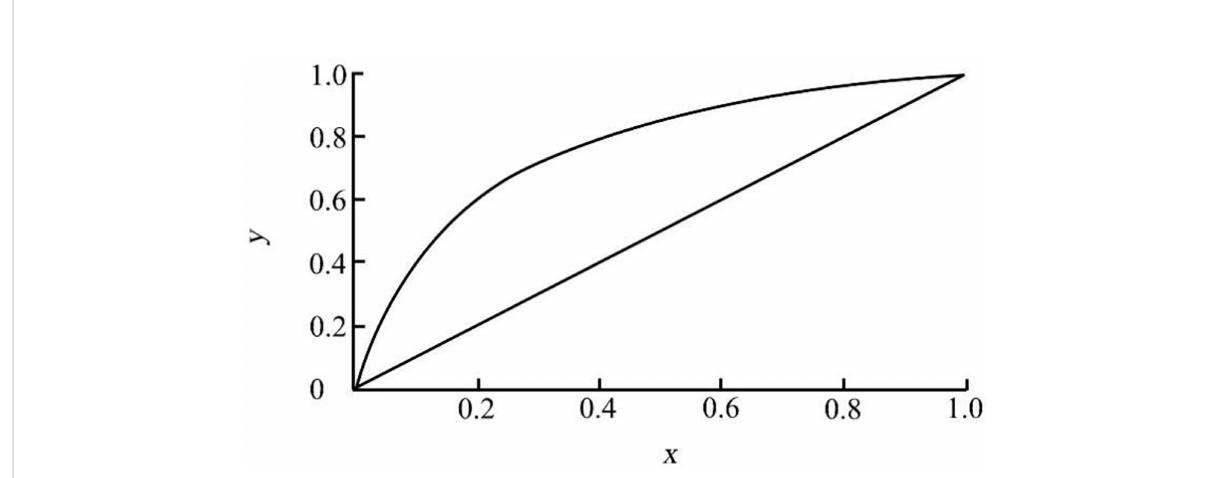
FIGURE 3 Comparison of two normalization